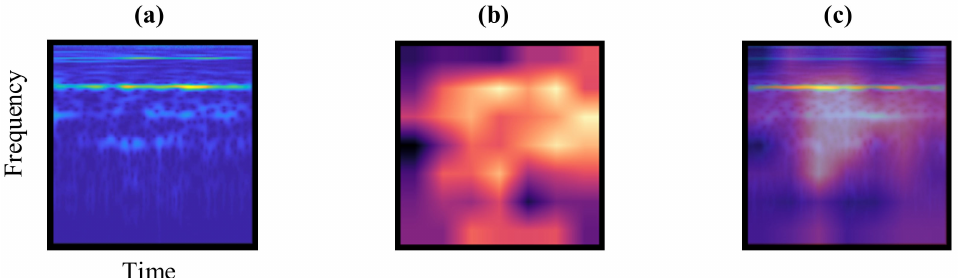
Figure 10. An exemplar illustration of heat map visualization: ( a ) input image, ( b ) average activation matrix, ( c ) heat